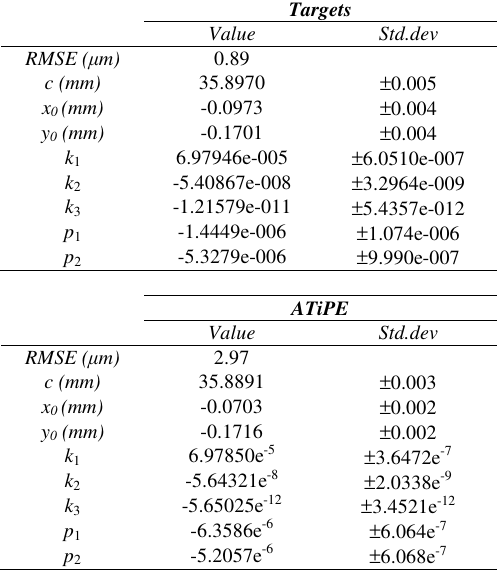
Table 1. Camera interior parameters estimated with the target-based approach and using ATiPE (targetless) method for a Nikon D700 mounting a 35 mm